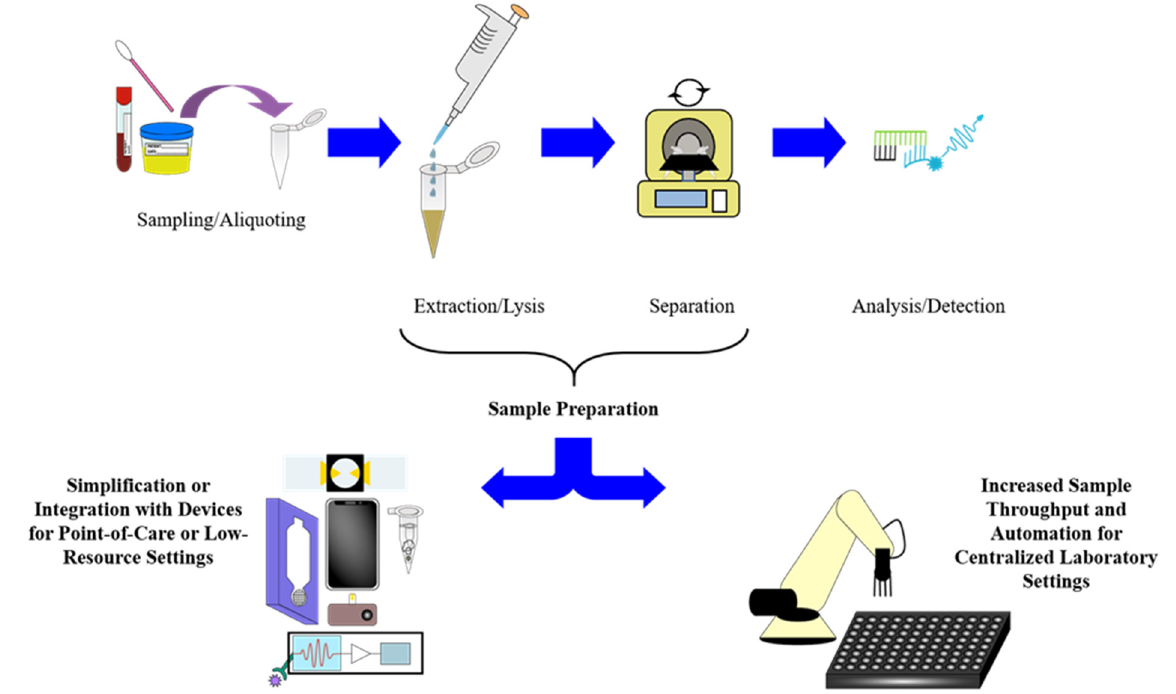
Figure 4. Simplified workflow of molecular diagnostic methods and two approaches to improving sample preparation in different settings.